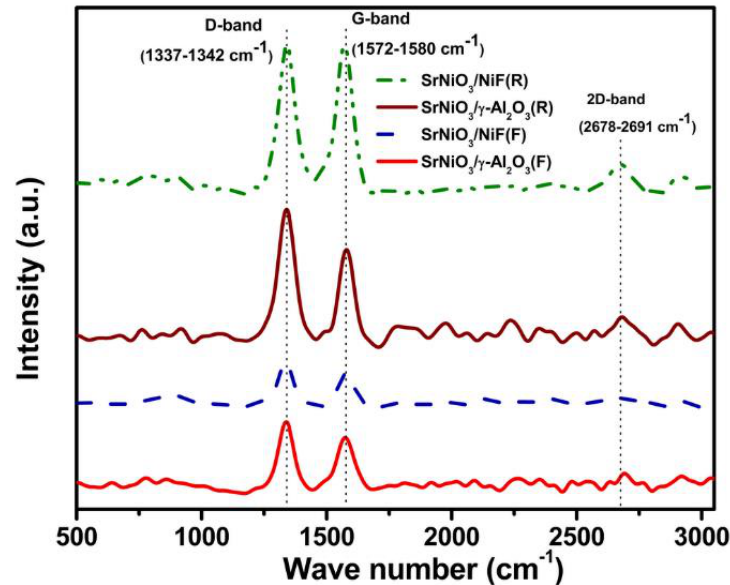
Figure 12. Raman spectra of spent catalysts after DRP over 50 h.